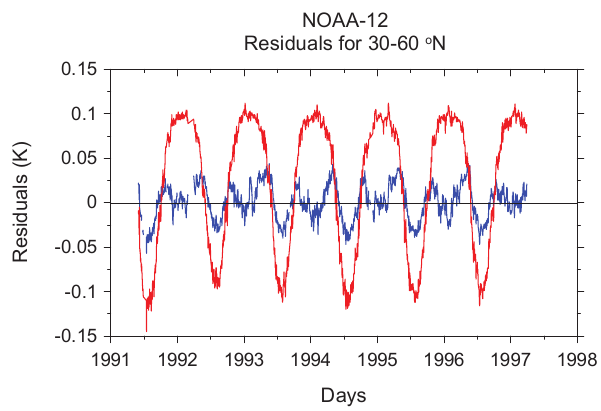
Figure 2. Relative error incurred to the prefactor ( 1 /P H ) of the Fig. 2. Relative error incurred to the prefactor (1 /P H ) of the UTH i UTH i calculation via errors in the estimated channel 6 brightness calculation via errors in the estimated channel 6 brightness temper- temperature, that is, due to the regression with T 6 / 4 . Measurement ature, that is due to the regression with T 6 / 4 . Measurement errors errors of T 6 / 4 are not taken into account for this calculation. The of T 6 / 4 are not taken into account for this calculation. The relative relative error is P H 1( 1 /P H ) = −[ (b 0 T 6 )/(a 0 + b 0 T 6 ) ]·[ (1T 6 )/T 6 ] . error is P H ∆(1 /P H ) = − [( b 0 T 6 ) / ( a 0 + b 0 T 6 )] · [(∆ T 6 ) /T 6 ] . The The red line represents the true values (0% error), the other lines red line represents the true values (0% error), the other lines show show the relative errors of 1 /P H for ± 0 . 05% (outer lines in green the relative errors of 1 /P H for ± 0 . 05 % (outer lines in green and and light blue) and for ± 0 . 03% error in T 6 (inner dark blue and light blue) and for ± 0 . 03 % error in T 6 (inner dark blue and violet violet curves).